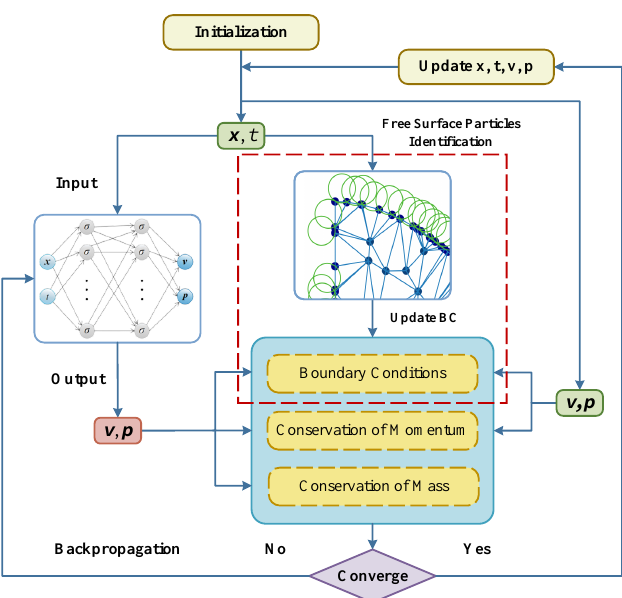
Figure 2. Flowchart of the improved NPM for a two-dimensional free surface flow problem.